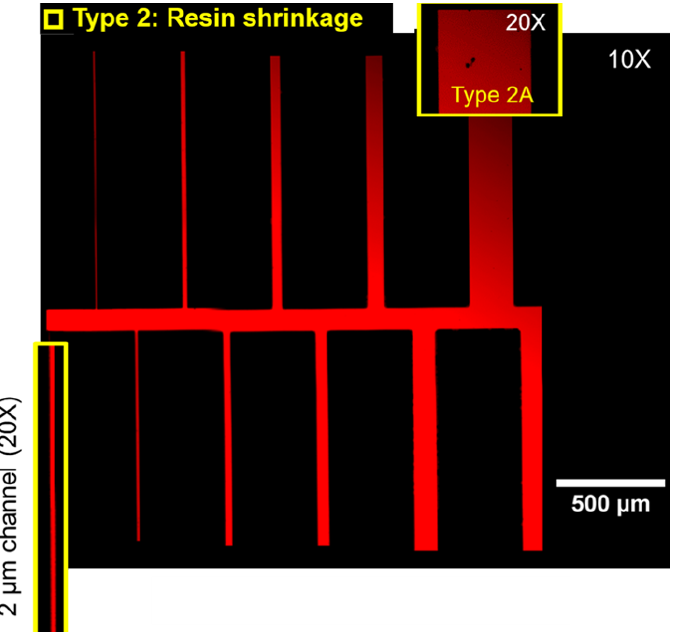
Figure 9. Confocal image of the silicon micromodel impregnated by resin mixed with fluorescent dye under high pressure preceded bya degassing step at a low vacuum level, 120 mbar. No trapped gases were observed even at the smallest channel, which shows the importance of the degassing step, while type 2 shrinkage defects were still persistent but with less severity due to the lower vacuum level used at the degassing